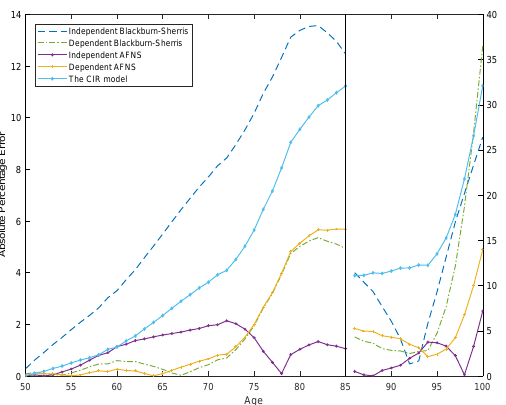
Figure 10. Absolute Percentage Errors between Actual and Best-Estimate Survival